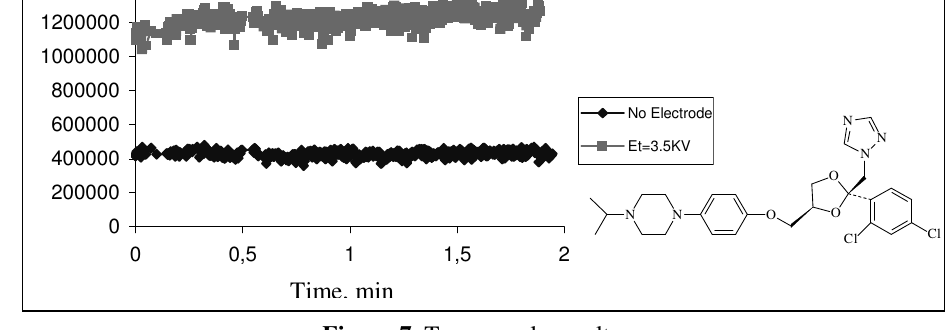
Figure 6. Midazolam Results Figure 7. Terconazole Results